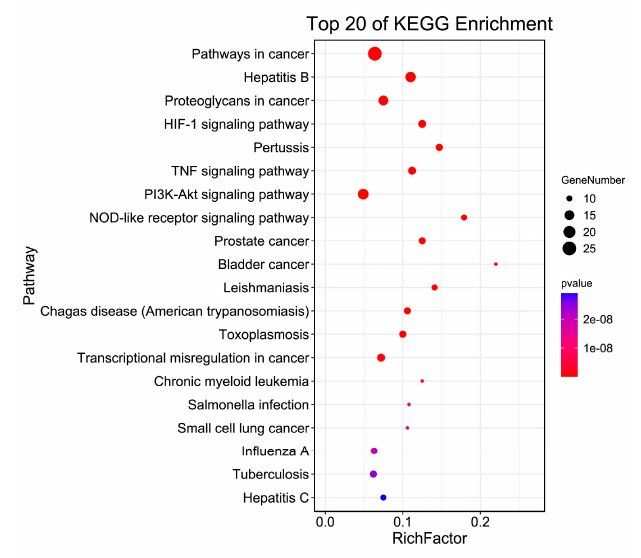
Figure 4. The KEGG analysis for the potential targets of wogonin against PH. The color represents the different p -values (<0.05), while the size of the circle represents the count.